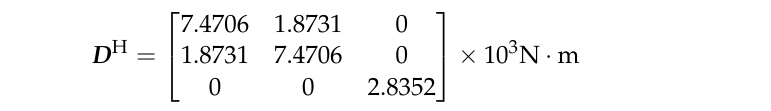
( f ) Figure 10. Third-order influence function 𝝌 3 of the CCCC single-layer periodic plate. (𝐚) 𝑚𝑛𝑝 = 111 ; (𝐛) 𝑚𝑛𝑝 = 221 ; (𝐜) 𝑚𝑛𝑝 = 121 ; (𝐝) 𝑚𝑛𝑝 = 112 ; (𝐞) 𝑚𝑛𝑝 = 222 ; (𝐟) 𝑚𝑛𝑝 = 122 .